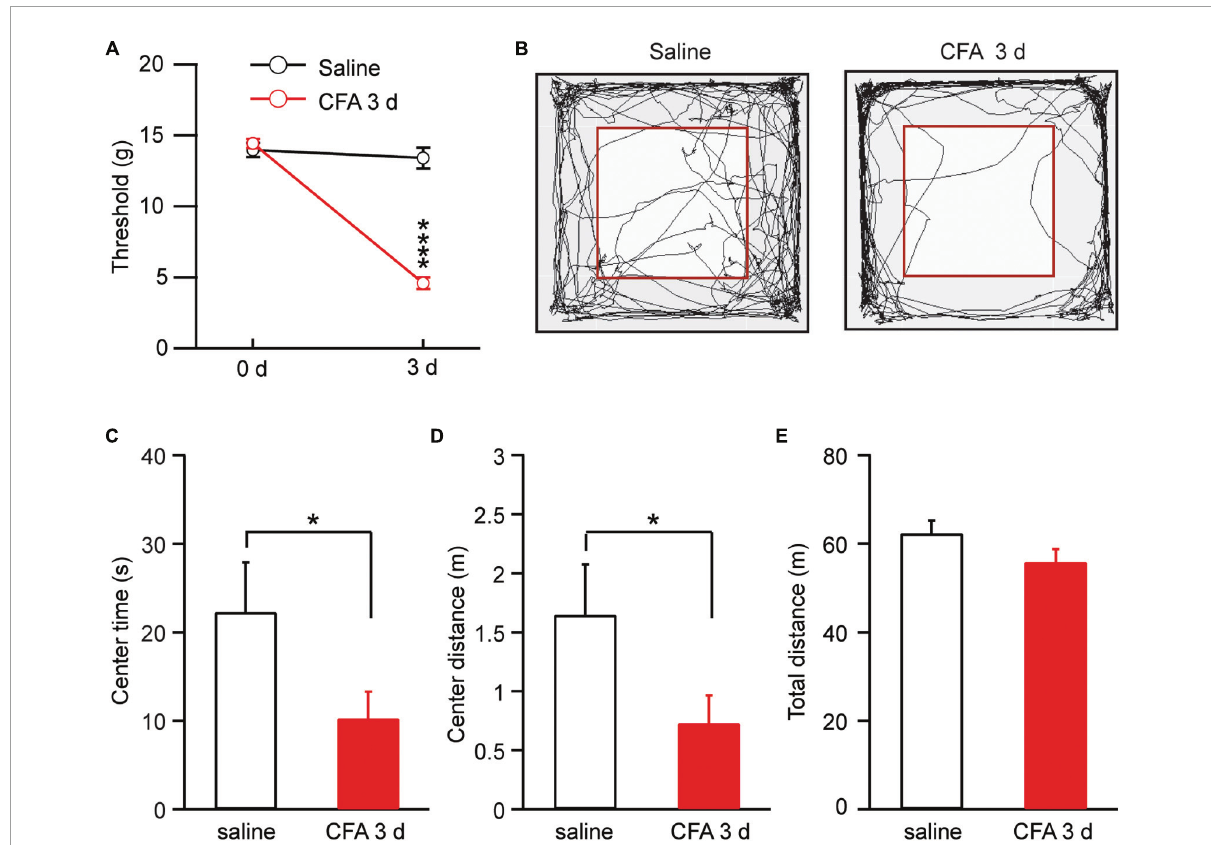
FIGURE1 Persistent pain induces anxiety-like behavior. (A) Thresholds of mechanical pain in rats 3 days after an intra-paw injection of saline ( n = 15) or complete Freund’s adjuvant (CFA, 50 µ l, n = 17). (B) Locomotion traces of a rat injected with saline or CFA in an open field test. The squares inside the chamber mark the central zone. (C–E) Group data of the time the rats spent in the central zone (C) , and distance the rats traveled in the central zone (D) and in the entire test chamber (E) during the test for the saline and CFA groups of rats. * p < 0.05 and **** p ≤